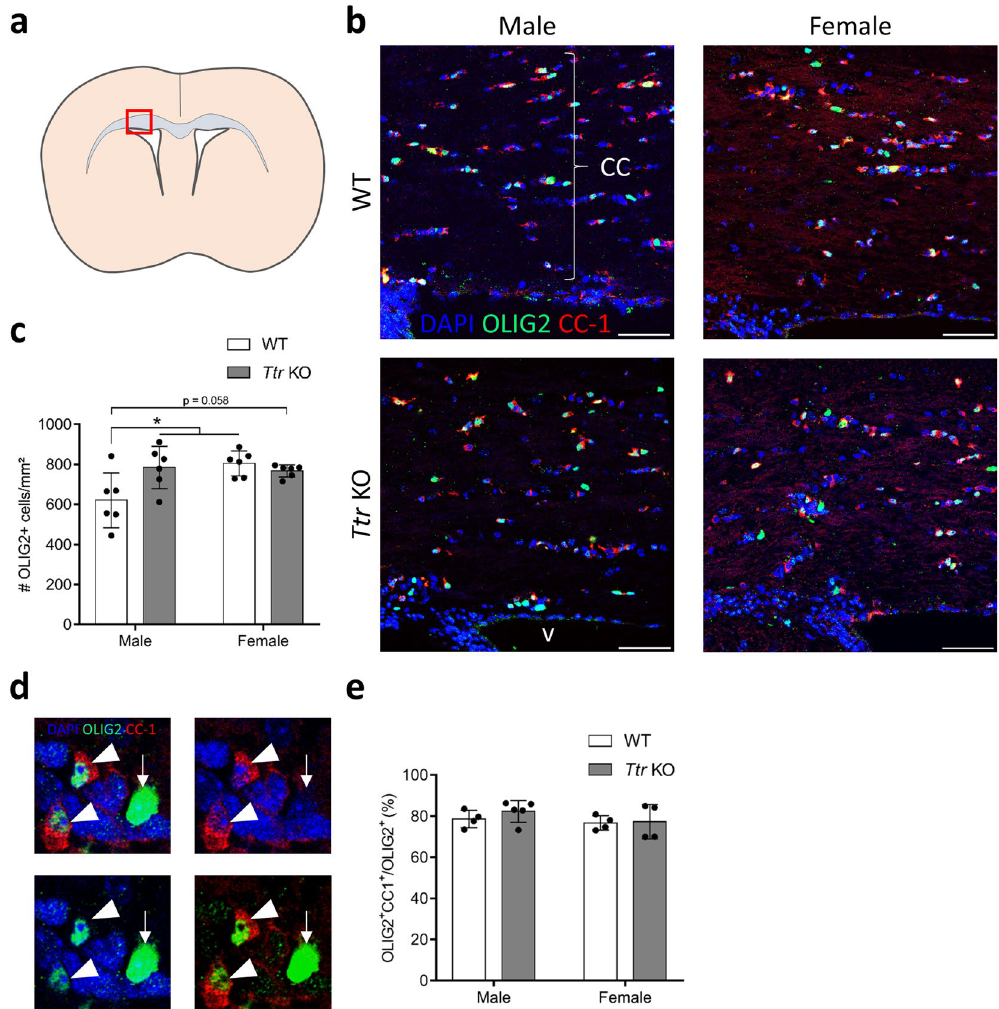
Figure 4. Ttr KO results in increased pOPC numbers in the corpus callosum of male mice only. ( a ) Schematic representation of the region of interest (corpus callosum, red box). ( b ) OLIG2 + oligodendroglial cells (green) are abundantly present in the corpus callosum of WTs. The majority of them are mature oligodendrocytes also expressing CC-1 (red). Scale bars: 50 µ m. ( c ) Statistical analysis revealed that OLIG2 + cell number per mm² in WTs is higher in females, and that Ttr KO results in a significantly increased pOPC number in males only, reaching WT female values (n = 6, two-way ANOVA, followed by Tukey Post-hoc test). ( d ) Detailed pictures showing mature oligodendrocytes co-expressing OLIG2 (green) in the nucleus and CC-1 (red) in the cytoplasm (arrowheads), while immature pOPCs only express OLIG2 (arrow). ( e ) The proportion of OLIG2 + cells co- expressing CC-1 does not differ statistically between all groups (n = 4–5, two-way ANOVA). Bars represent mean ± SD. CC: corpus callosum; v: ventricle. * P <